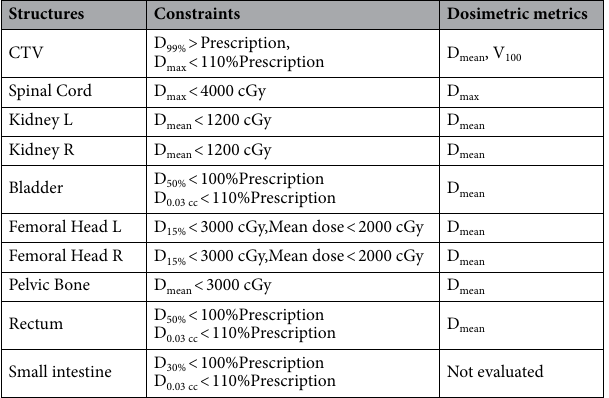
Table 1. The constraints and dosimetric metrics for EBRT planning structures. CTV: clinical target volume; Kidney L/R: left/right kidney; Femoral Head L/R: left/right femoral